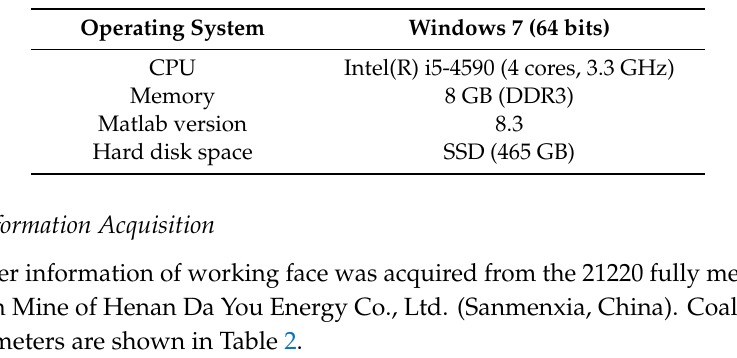
Table 2. Coal mining face and equipment parameters.